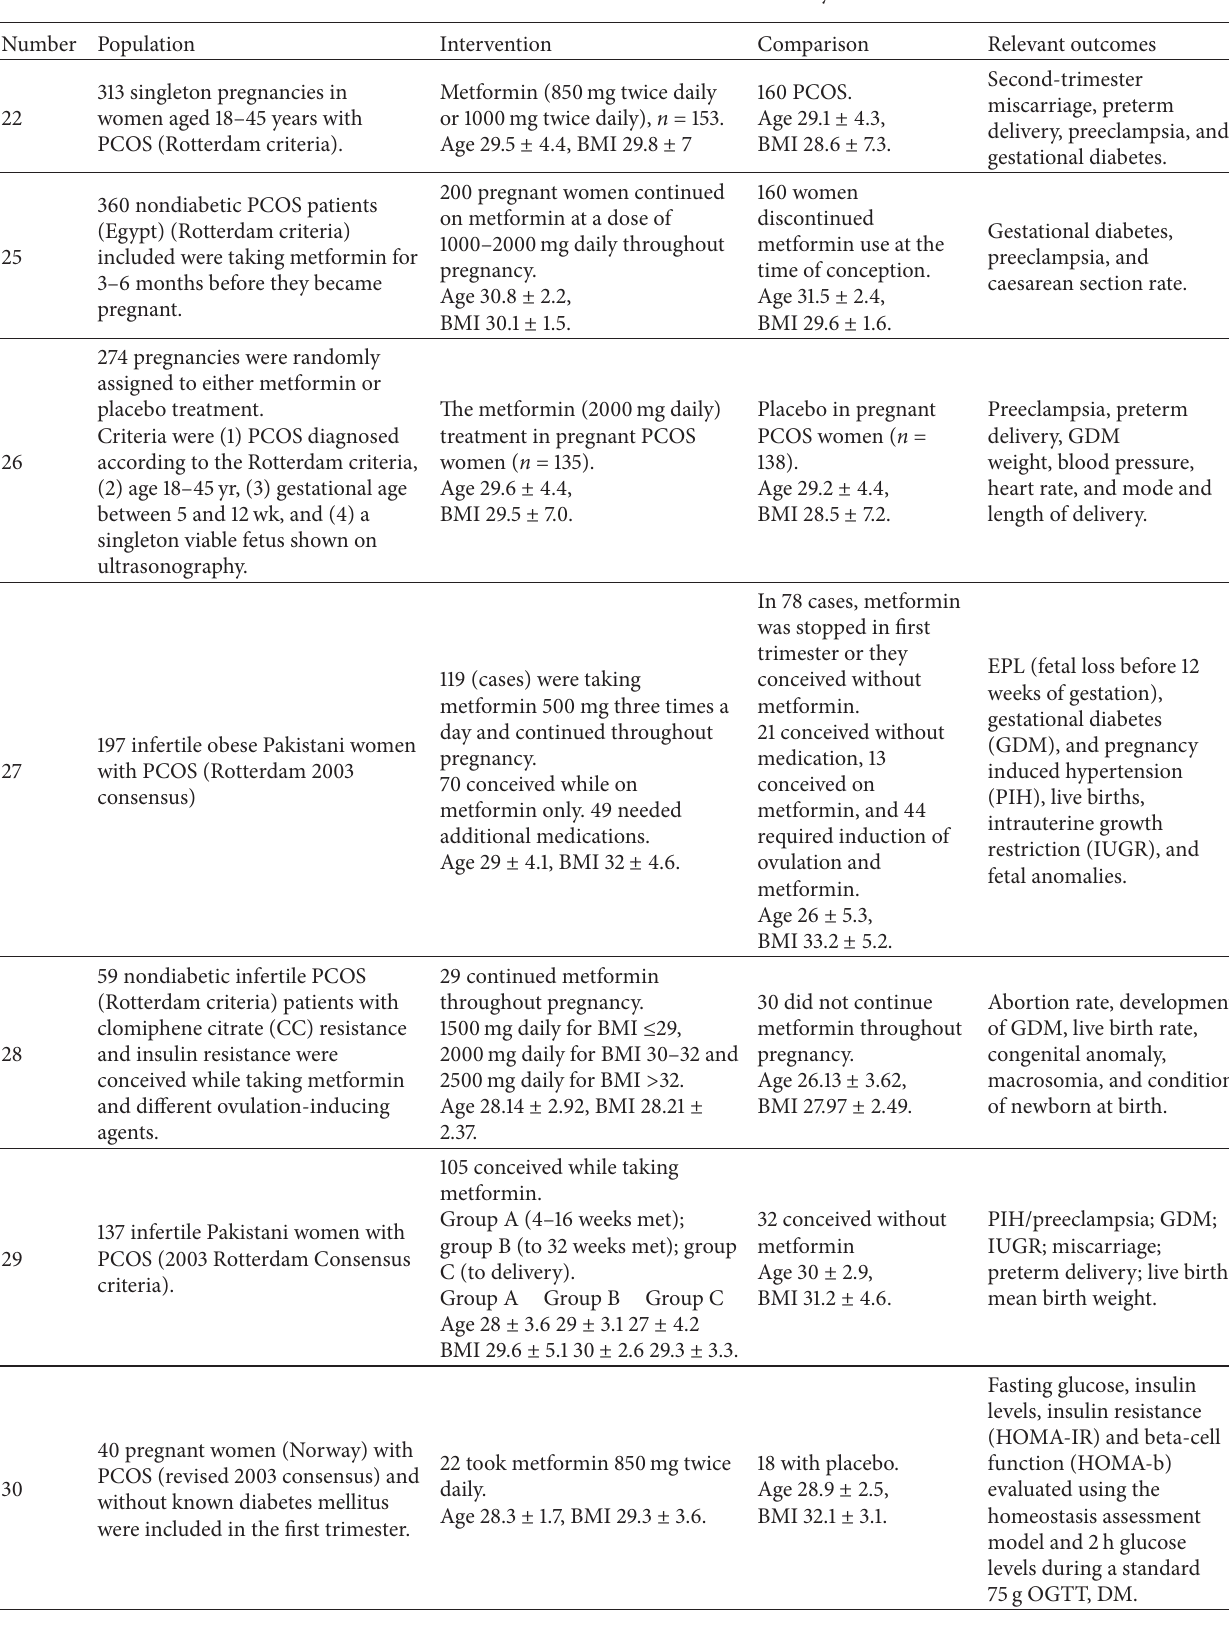
Table 2: Characteristics of trials in the